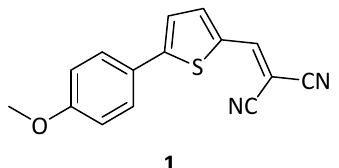
Figure 1. Thiophene dicyanovinyl derivative 1 .